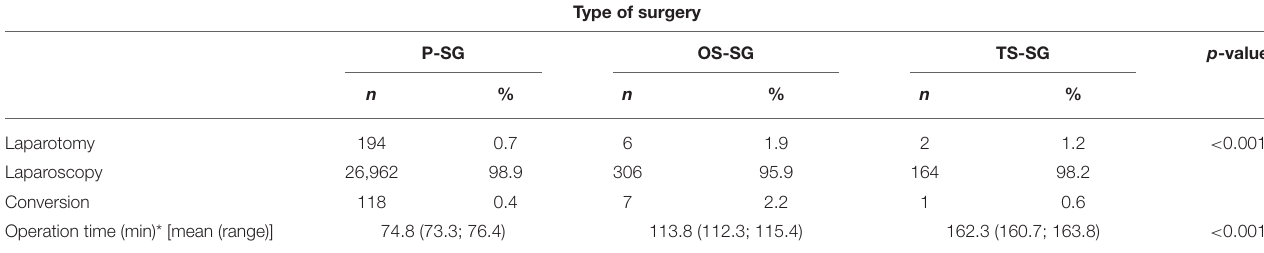
TABLE 3 | Operative data.